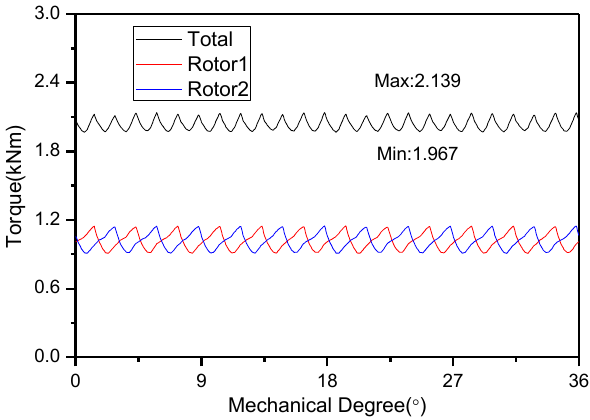
16 of 18 Figure 25. Diagram of the stator with two twisted modules.